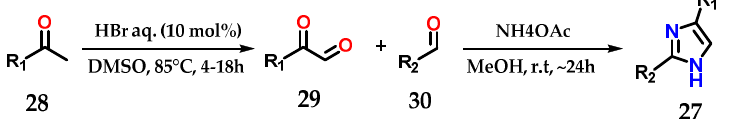
Figure 14. Synthesis of disubstituted imidazoles 27 starting from the acid-catalyzed oxidation of methylketones 28 .